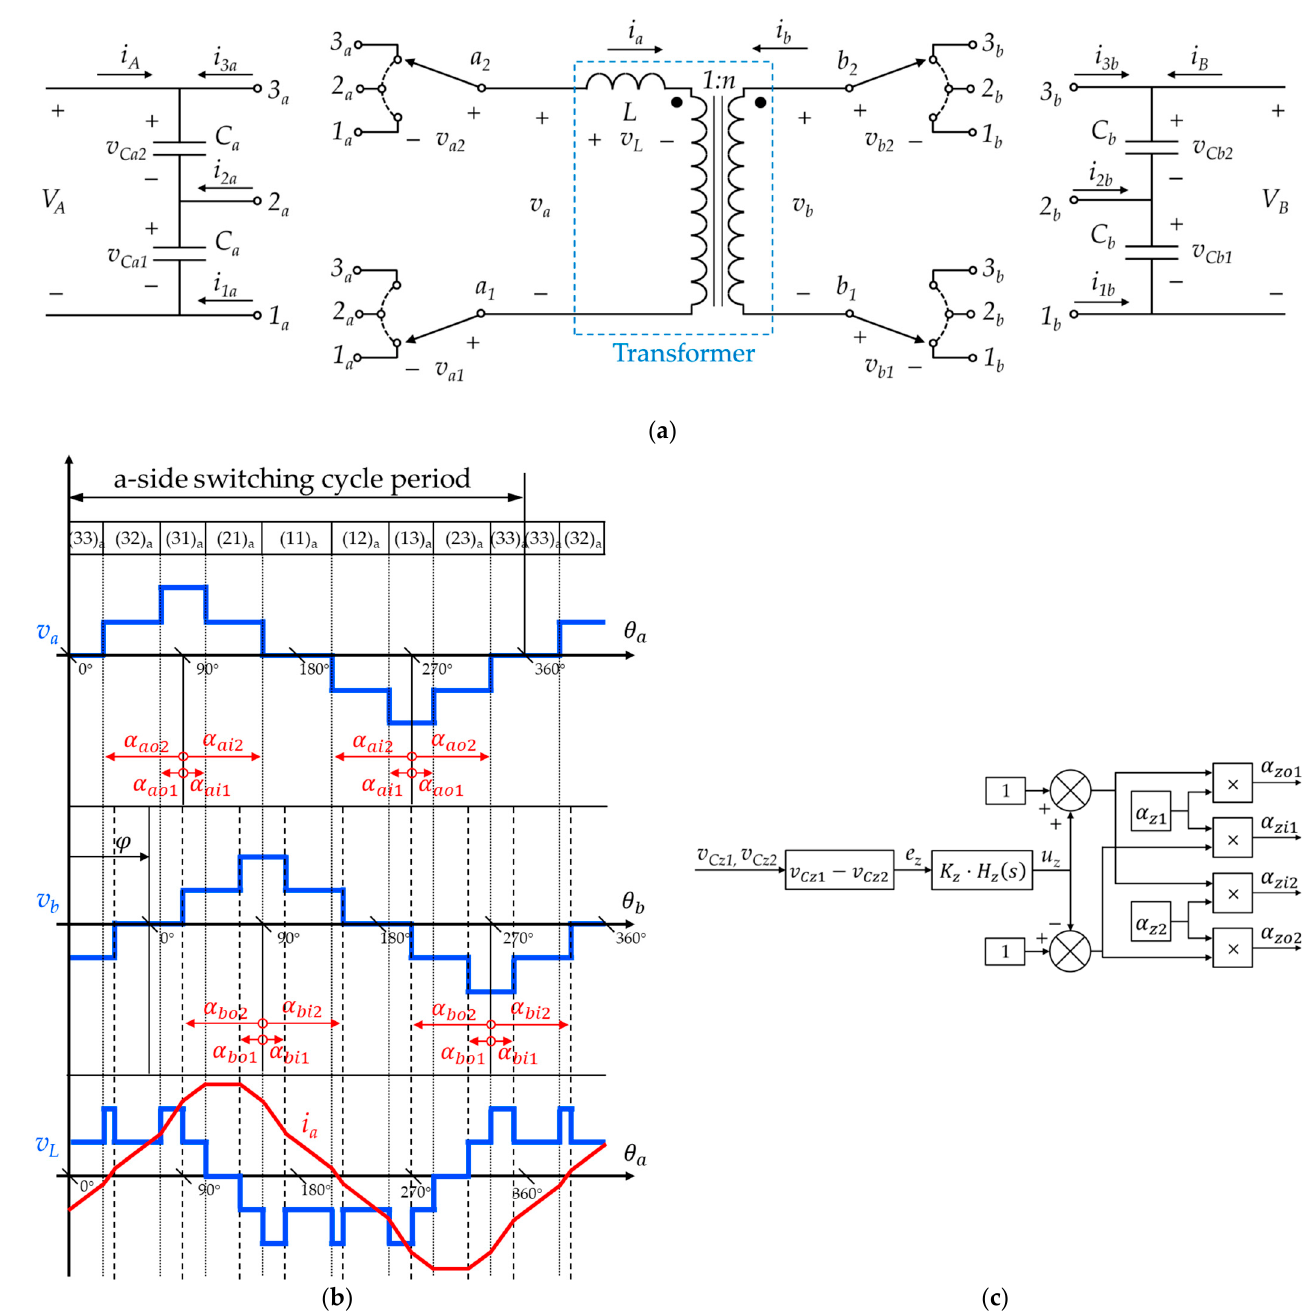
Figure 17. Three-level DAB DC–DC converter [163]: ( a ) Topology with phase legs a 1 , a 2 , b 1 , and b 2 depicted as single-pole triple-throw switches; ( b ) voltage waveforms v a , v b , and v L , and current waveform i a for the proposed modulation. The switching states for a-side are shown on top of the figure. All waveforms are plotted assuming V A = V B / n . ( c ) Control scheme for the capacitor voltage